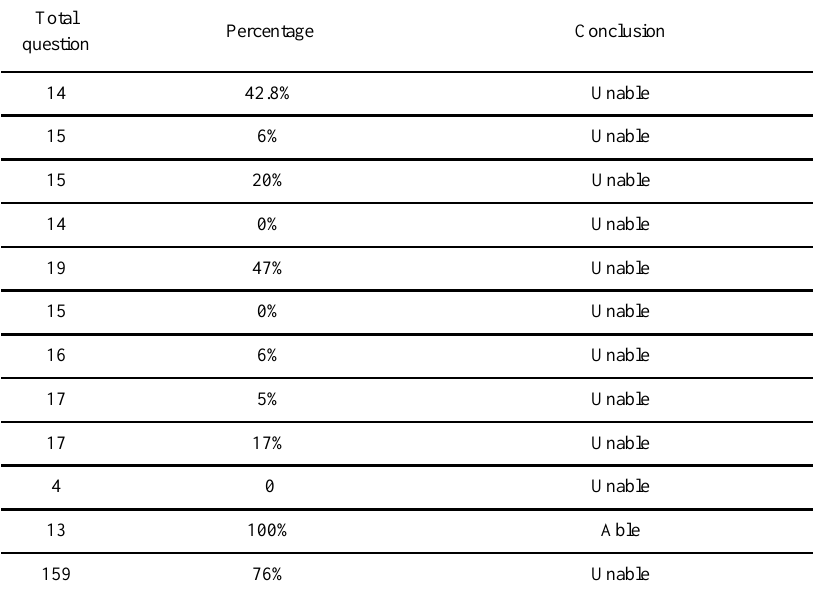
Table 4.1. Ability of the teenager to speak in Sundanese The reasons for their inability in speaking of language in Sundanese teen- agers in Batam